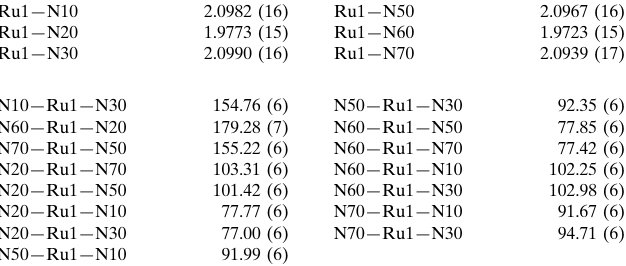
Selected geometric parameters (A˚ , (cid:1) ).